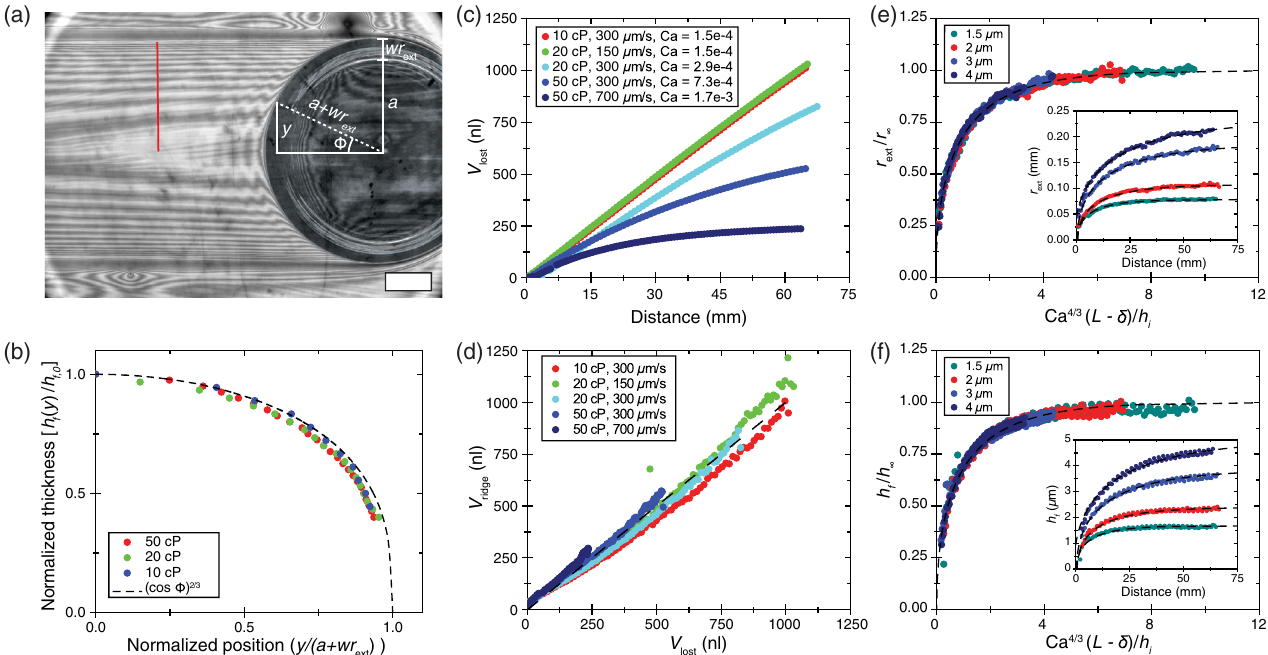
FIG. 6. (a) RICM of a droplet moving on SLIPS, including the geometric components used to describe the shape of the lubricant behind the droplet (scale bar ¼ 1 mm). (b) Normalized thickness profiles behind the droplet calculated using RICM intensity profiles [for example, along the red line in (a)] in combination with white-light interference measurements. In all cases, h vs distance for droplets moving with various capillary numbers over silicone oil SLIPS with h and U ¼ 300 μ m = s. (c) V lost (d) V vs V for experiments on silicone oil with various capillary numbers. The sole fitting parameter α ¼ 0 . 52 . (e),(f) ridge lost Nondimensional plots of the growth of r and h with distance for droplets moving at 700 μ m = s on 50-cP silicone oil with various f; 0 ext initial thicknesses (insets show dimensional quantities). Dashed lines indicate best-fit lines predicted by Eq.